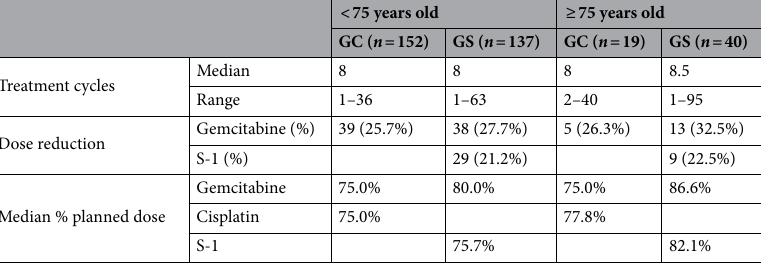
Table 2. Treatment compliance according to age in GC and GS. GC, gemcitabine plus cisplatin; GS, gemcitabine plus